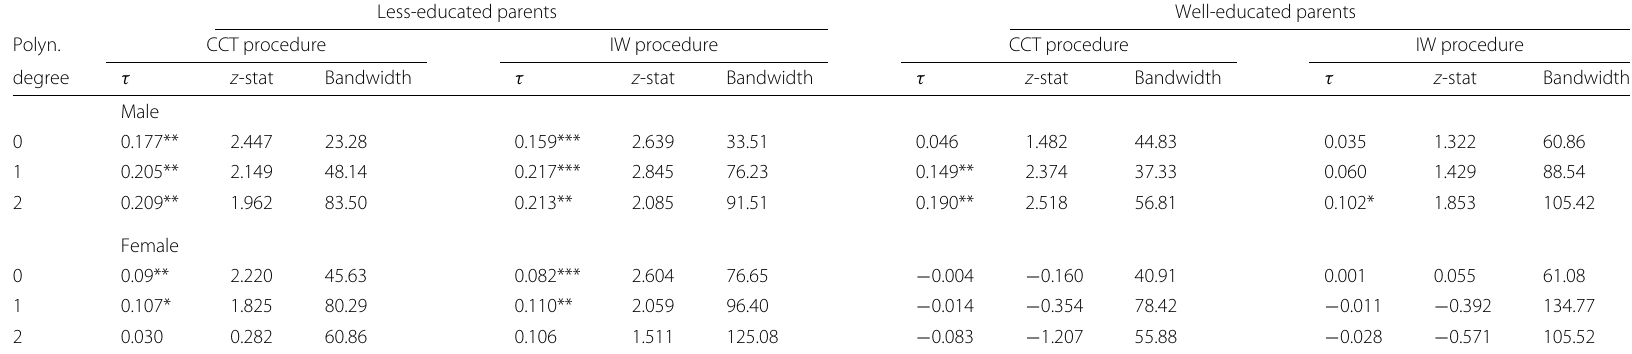
Table 5 RD estimates of test scores by parental education